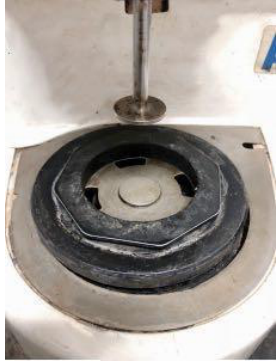
Figure 5. The parallel plates.